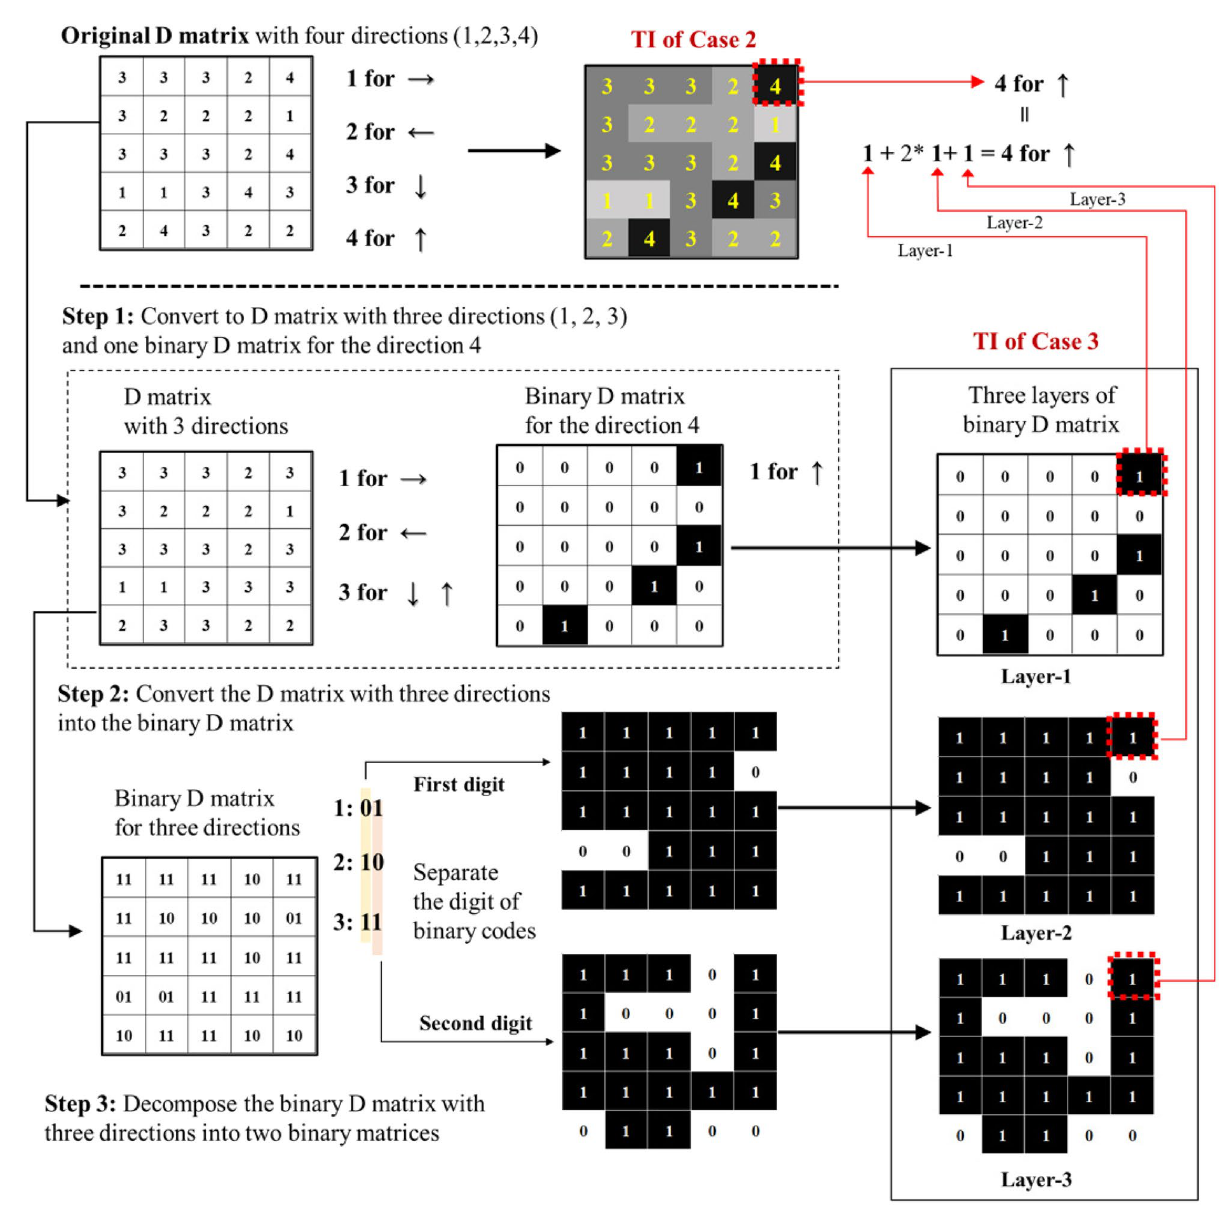
Figure 5. Conversion of the D -matrix into the connectivity-informed D -matrix. Constraints of the directional information on connectivity were achieved by separating the D -matrix into several layers of binary matrices for the directional information to provide physics-informed constraints between different